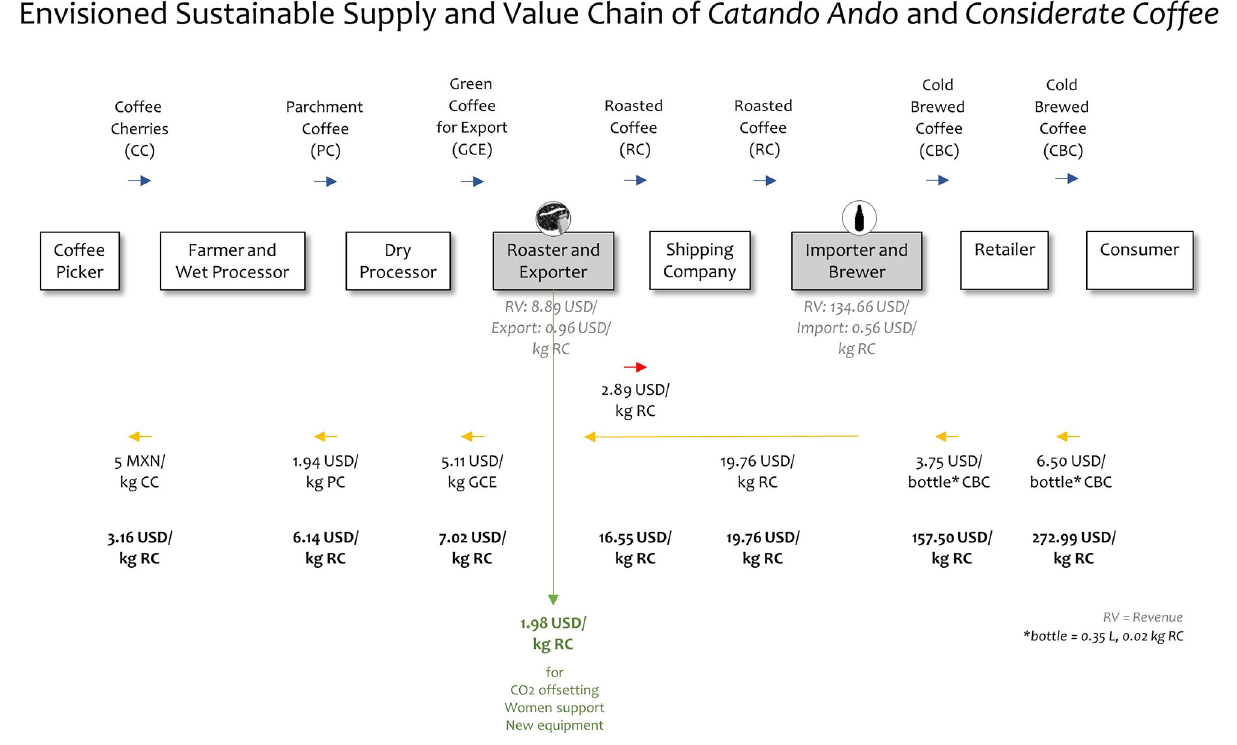
FIGURE 3 | Envisioned sustainable coffee supply chain between Considerate Coffee and Catando